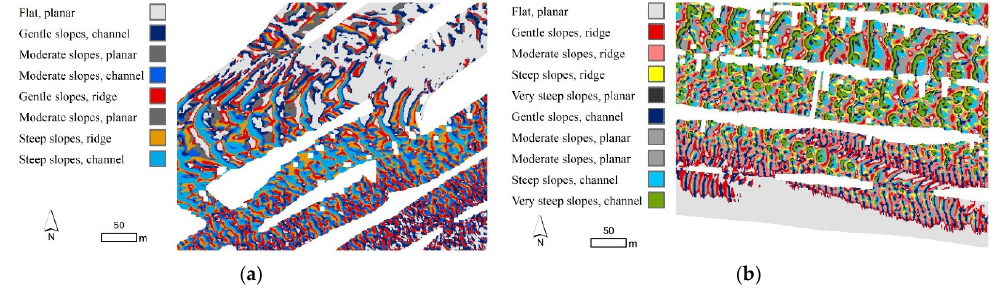
Figure 5. SOM technique-based distribution of geomorphic elements for the sample data of ( a ) Chizhou Reach and ( b ) the Yangtze Estuary.